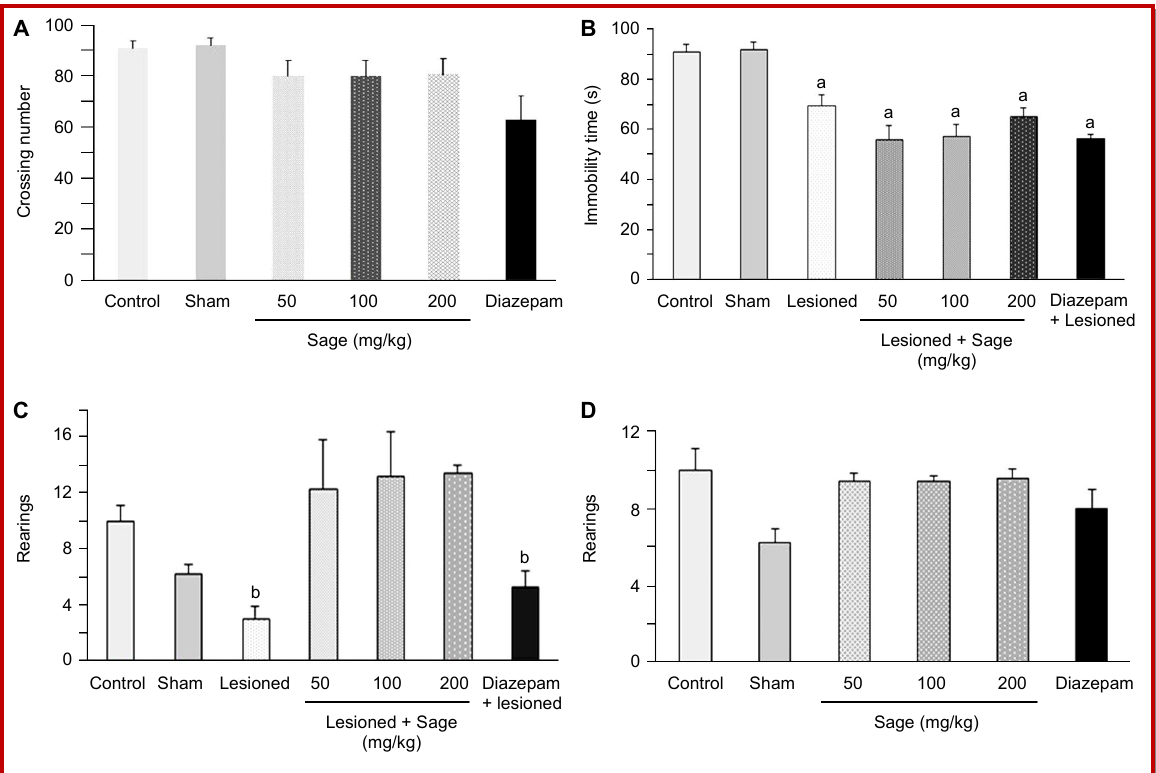
Figure 6: Open-field activity of rats. Intact and hippocampal-lesioned were treated with S. officinalis (50, 100 and 200 mg/kg i.p) or diazepam (1 mg/kg i.p) (A, B); Number of crossings during the 5 min session. (C,D) Number of rearings during the 5 min session. Values are the means ± S.E.M. (n = 6). a p< 0.001, b p< 0.05 as compared to the normal control